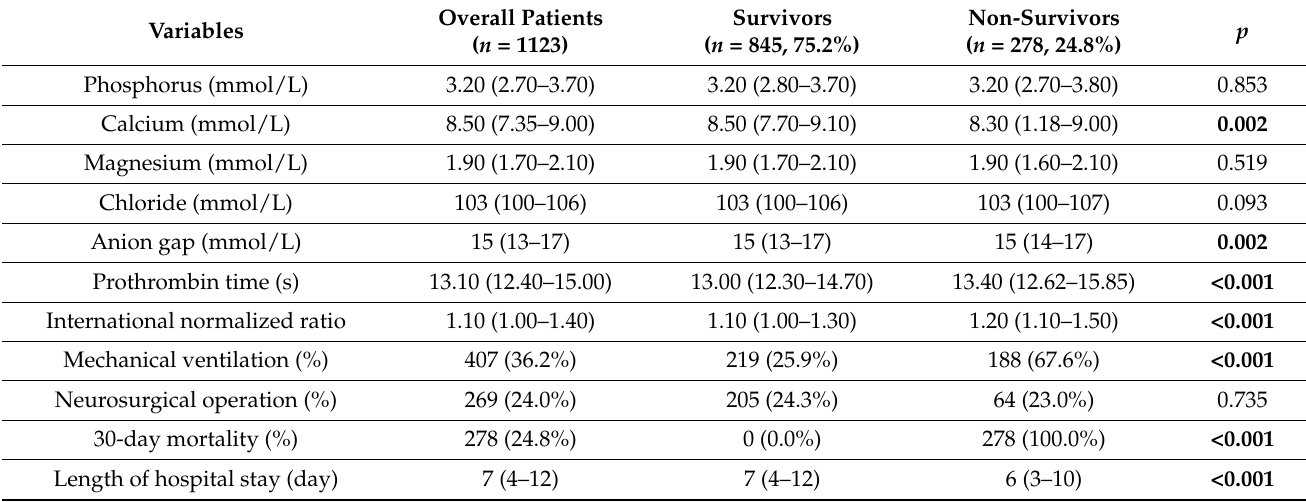
Figure 3. ( a ) The importance of the top 20 features in the Adaboost model; and ( b ) the importance of the top 20 features in the Random Forest model.